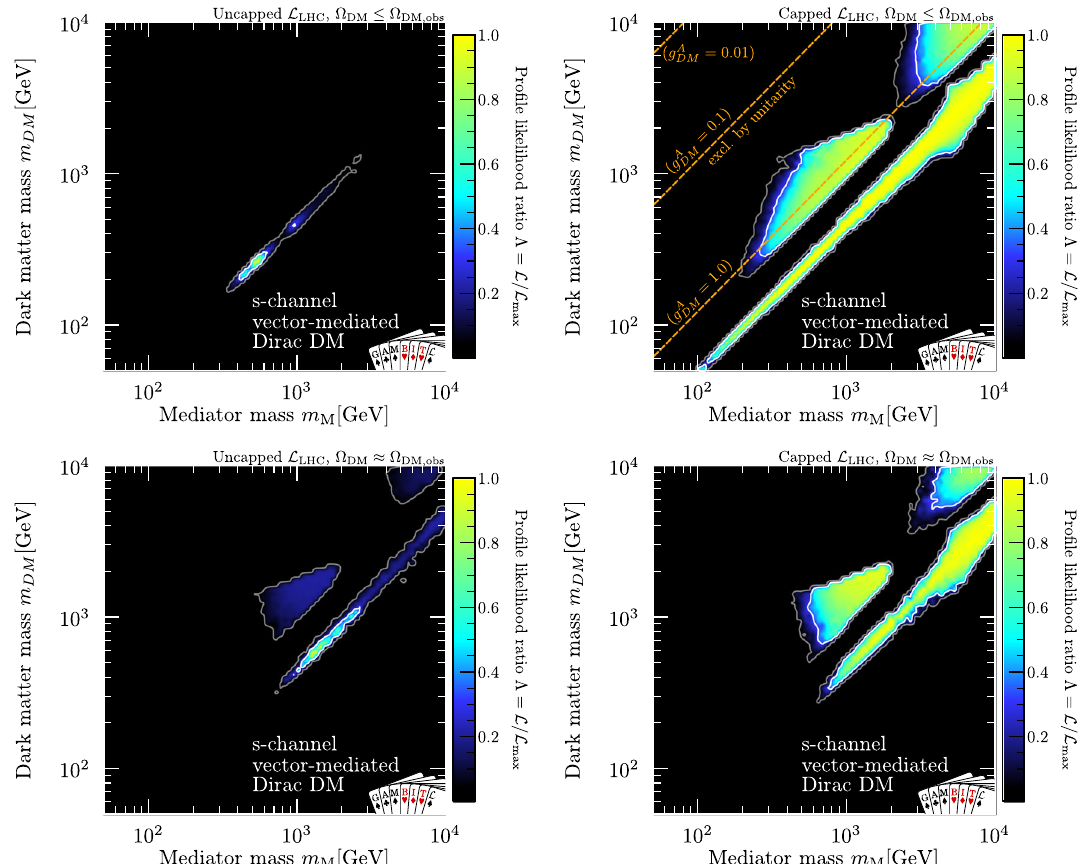
Fig. 4 Profile likelihood for the Dirac fermion DM model. The observed relic density of DM is taken as an upper limit (top) or to consist entirely of the Dirac DM candidate (bottom). The collider like- Fig. 5 Missing energy spectra for the CMS monojet search. The SM background prediction (purple) and the observed event counts (black) are taken from Ref. [65]. The green distribution shows the signal prediction for the best-fit Dirac DM model. The bottom panel shows the residuals, defined as (data − prediction)/uncertainty for both the SM and the SM + DM